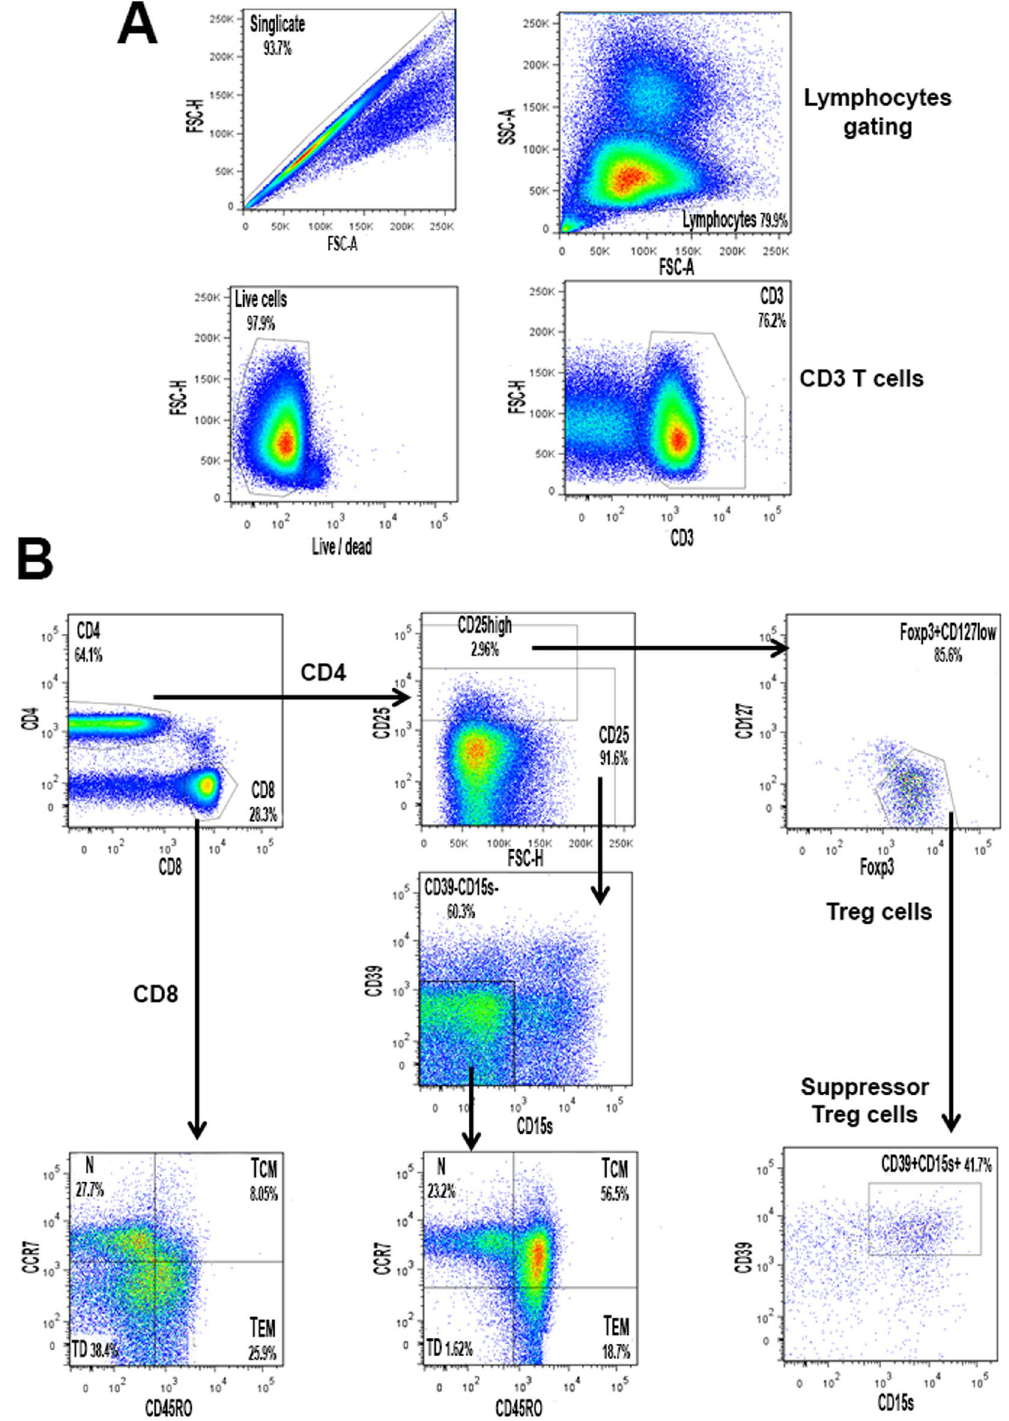
Figure 2. Gating strategy for T cell phenotyping in PBMCs. ( A ) Flow cytometry to identify T cell subsets in PBMCs was carried out in CTS and control subjects. Singlet cells were first gated, followed by gating of lymphocytes according to their size (forward-scatter) and granularity (side-scatter). Live cells were distinguished from dead cells using a staining kit (Live/dead UV450) and then gated for CD3 + cells. ( B ) CD3 + cells were differentiated into CD4 + and CD8 + T cells and further into naïve or memory cells. After antigen experience, memory T cells gain expression of CD45RO and lose expression of CD45RA. Thus, CD45RO was used to differentiate the naïve from memory populations. CC-chemokine receptor 7 (CCR7) divides human memory T cells into two functionally distinct subsets: Effector memory T (T EM ) cells that express low levels of CCR7 but have receptors for migration to inflamed tissues and display immediate effector function, and central memory T (T CM ) cells that express high levels of CCR7 that enable